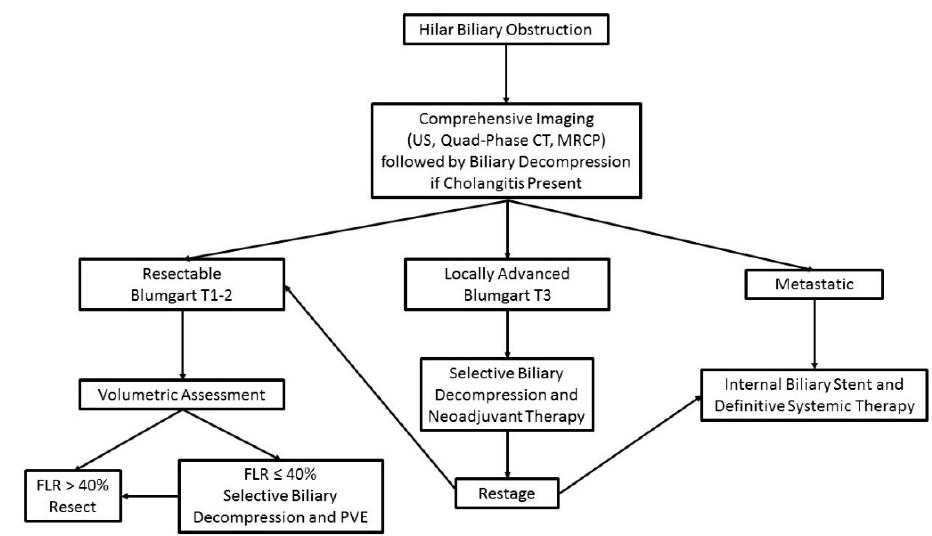
Figure 3. Algorithm for preoperative assessment and management of patients with perihilar chol ‐ angiocarcinoma.